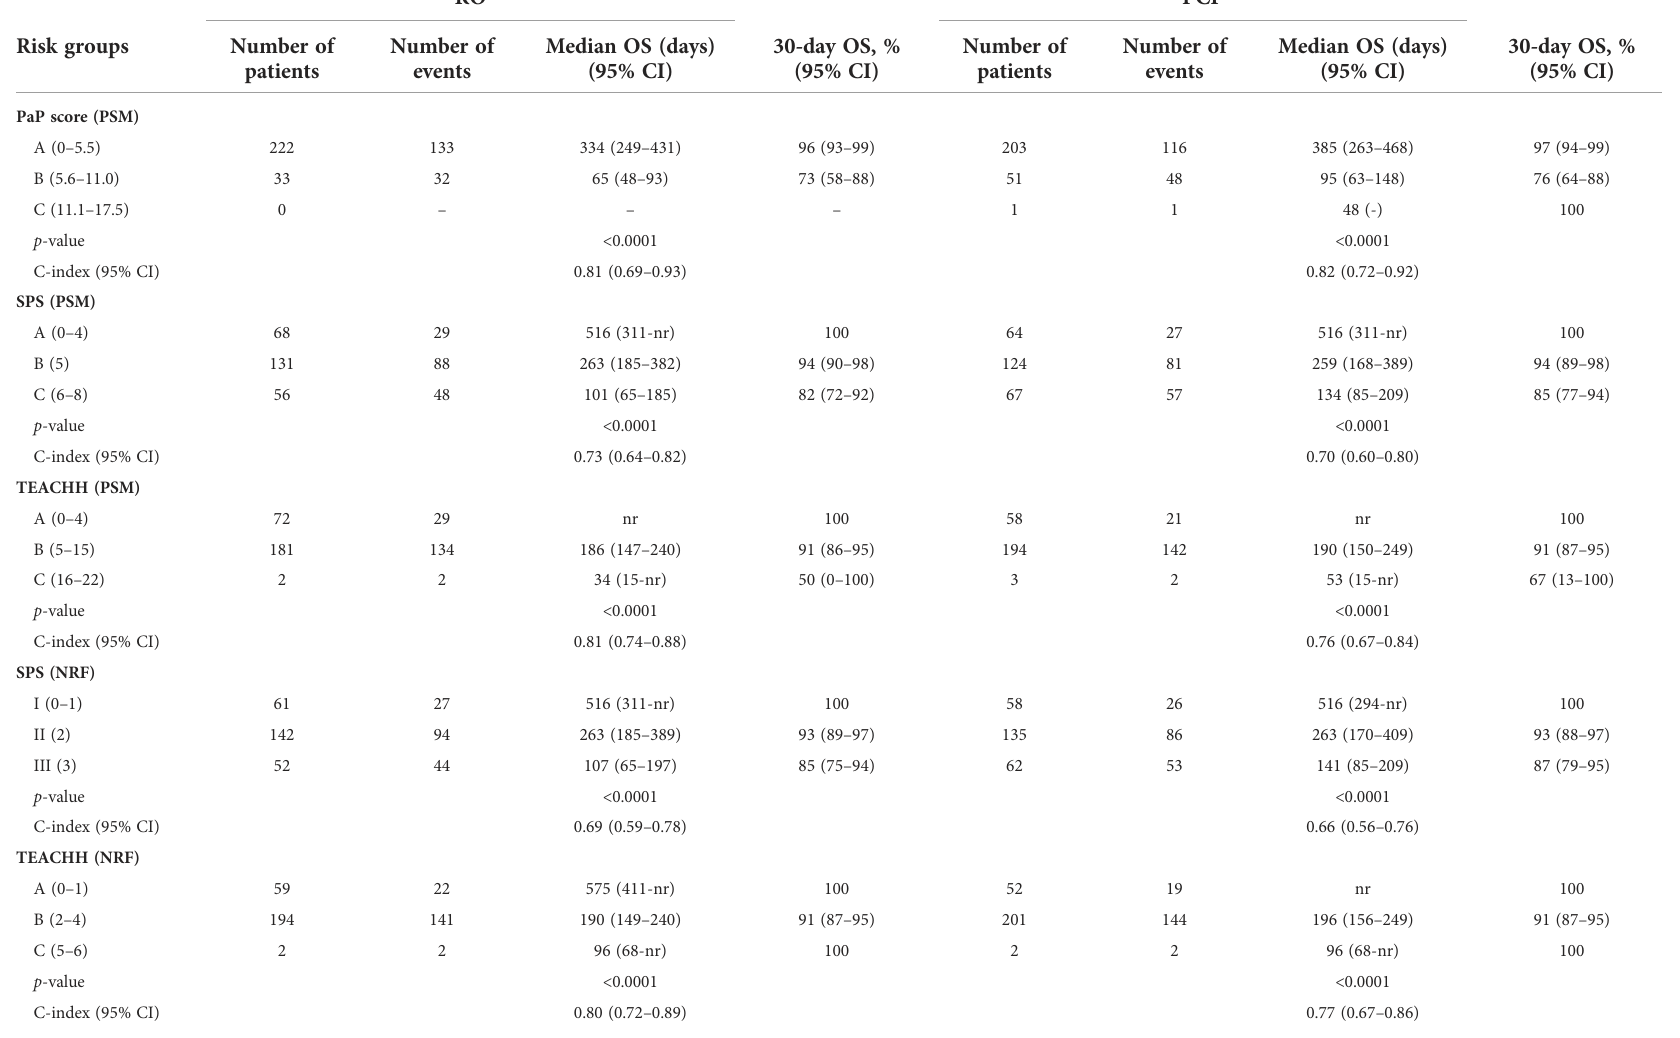
TABLE 3 Univariate analysis of overall survival (OS) according to scores and different